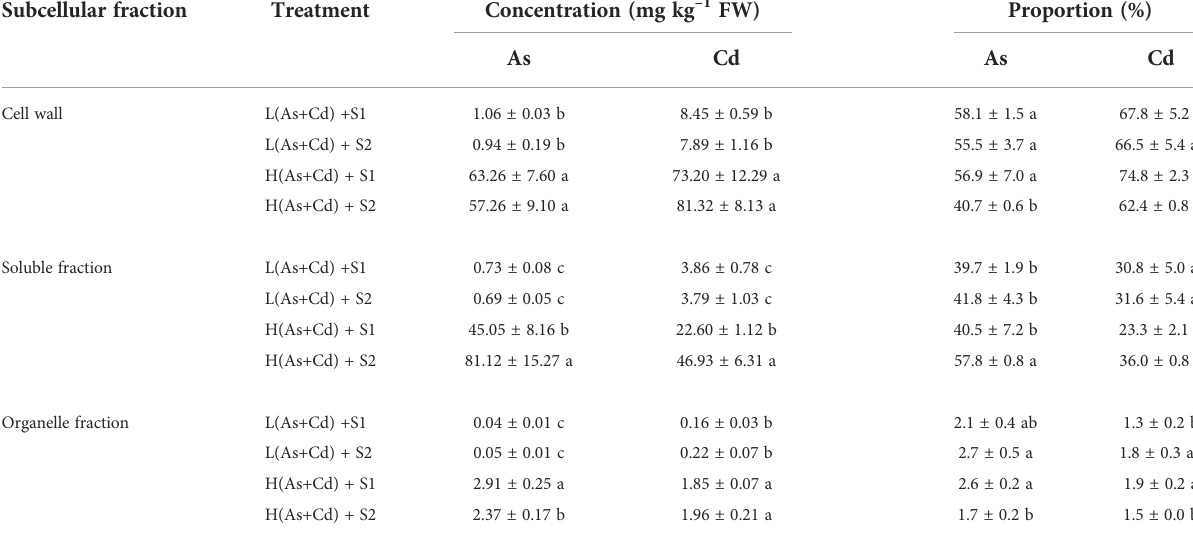
TABLE 1 Subcellular distribution of As and Cd in the roots of wheat plants grown in de fi cient S or suf fi cient S nutrient solution after 6 days of As plus Cd exposure. Subcellular